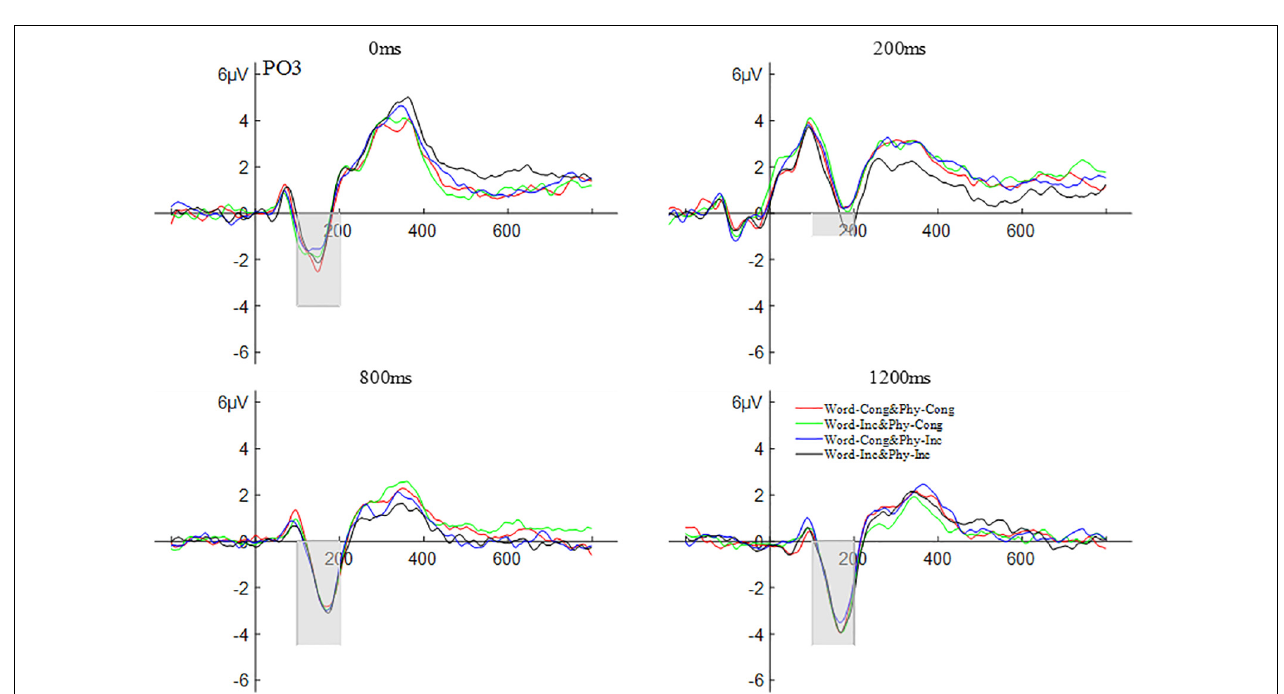
FIGURE 4 | The waveform of N1 word and physical congruency under different stimulus onset asynchrony conditions.